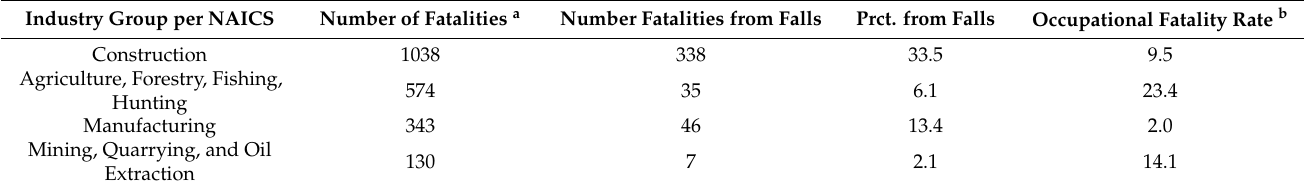
Table 1. US occupational fatalities and fatality rates in four major industries for the year 2018 [2,3]. Industry Group per NAICS